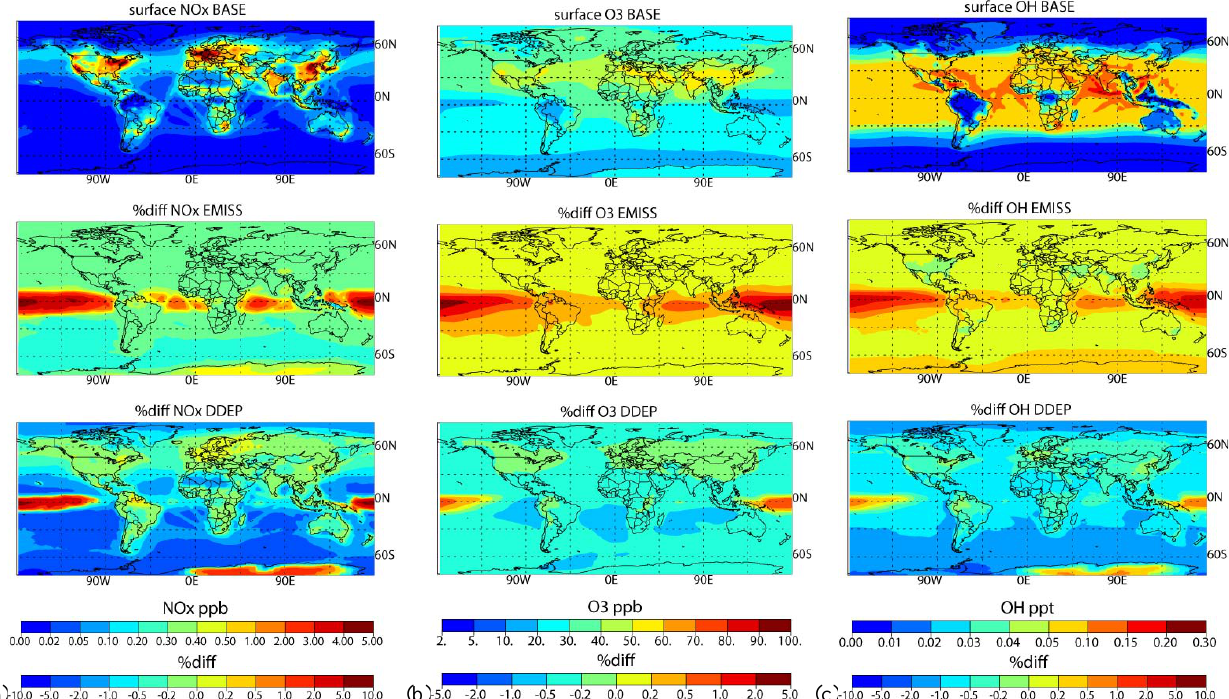
Fig. 12. (a) The annual surface distribution of NO x integrated below 800hPa (top), along with the percentage differences introduced in the EMISS (middle) and DDEP (bottom) simulations with TM5. The percentage differences are calculated according to (BASE- SENS/BASE) · 100. In TM5, NO x is defined as the sum of NO, NO 2 , HNO 4 , N 2 O 5 . (b) As in Fig. 10a, except for tropospheric ozone. (c) As in Fig. 10a, except for tropospheric